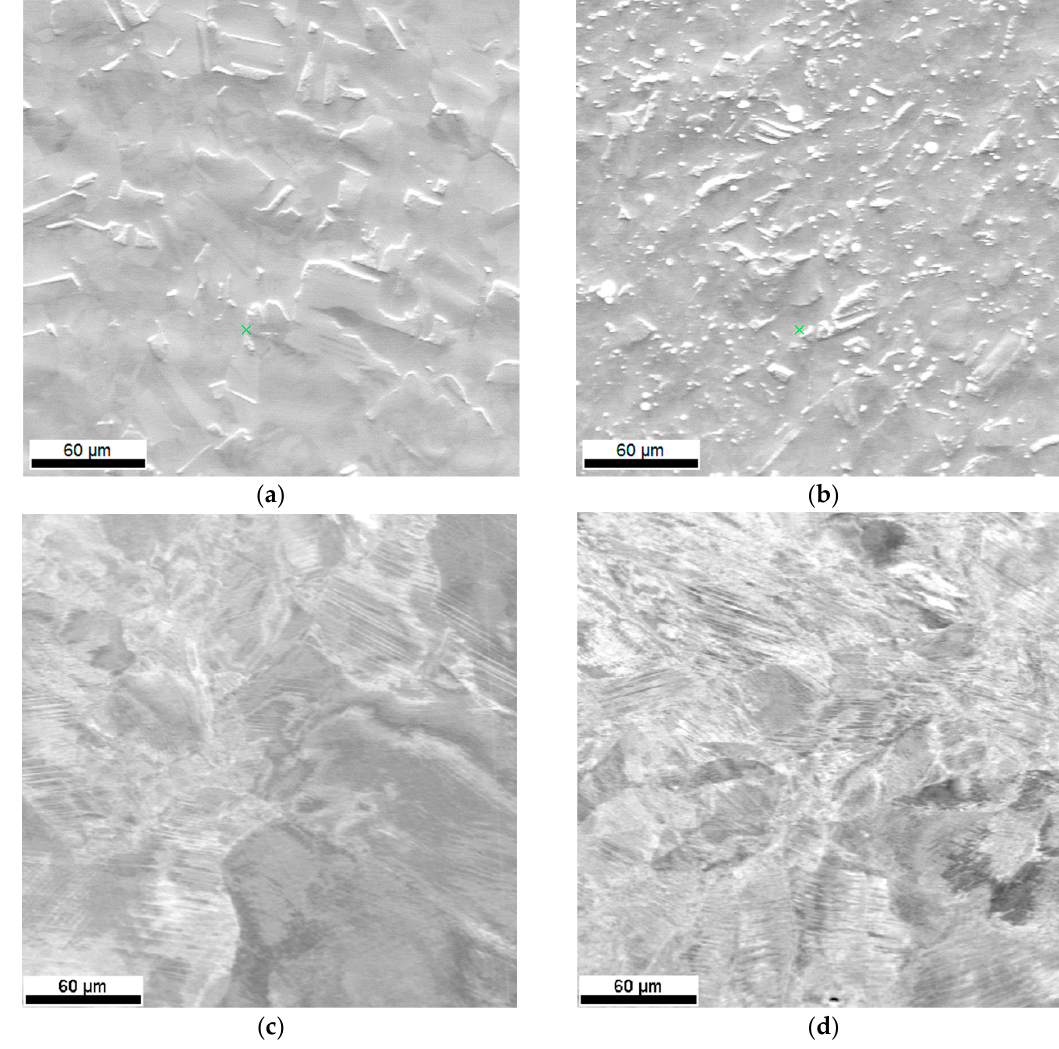
Figure 11. Comparison of the impact of dynamic plastic deformation on the microstructure of 316L hot-forged steel ( a , b ) and LENS ( c , d ), subjected to plastic deformation at a rate of ( a ) ε = 620 s − 1 , ( b ) ε = 3260 s − 1 , ( c ) ε = 970 s − 1 , ( d ) ε = 4100 s − 1 . Lee et al. in [19] investigated the 316L stainless steel rod subjected to dynamic load at 25 ◦ 800 C temperature with 1 × 10 3 s